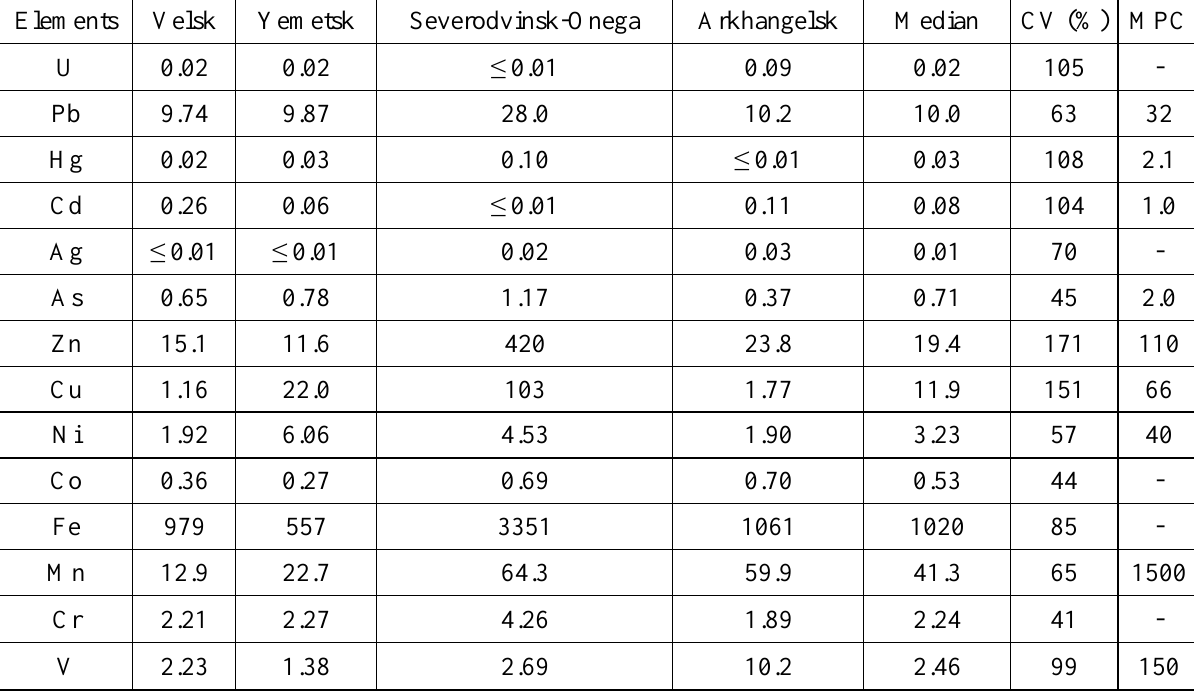
Table A1. The average concentrations of all elements (mg kg -1 ), median concentrations (mg kg -1 ) and coefficients of variation (CV) in the studied peat samples. Maximum permissible concentration (MPC) values (mg kg -1 ) for these metals in Russian soils from The List of MAC and TAC № 6229-91 (1994) are also